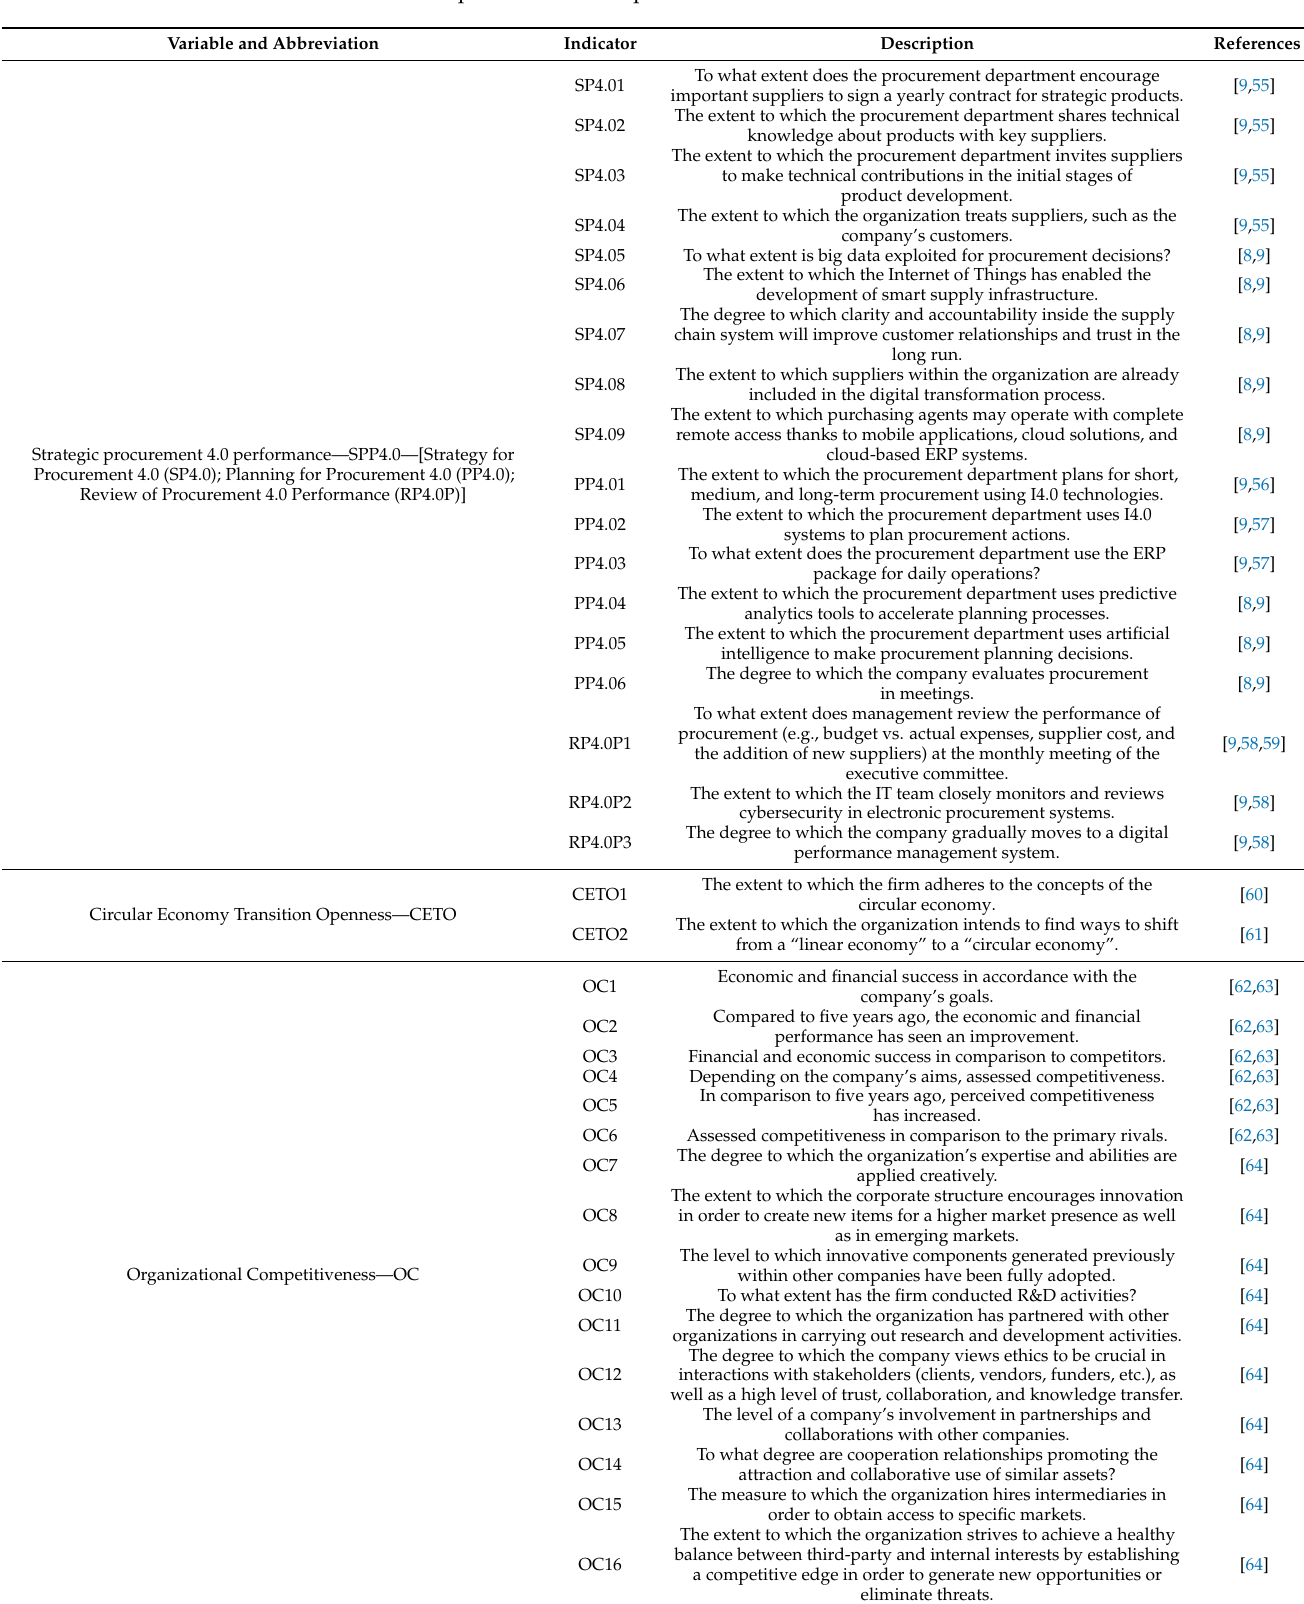
Table A1. Dependent and independent research